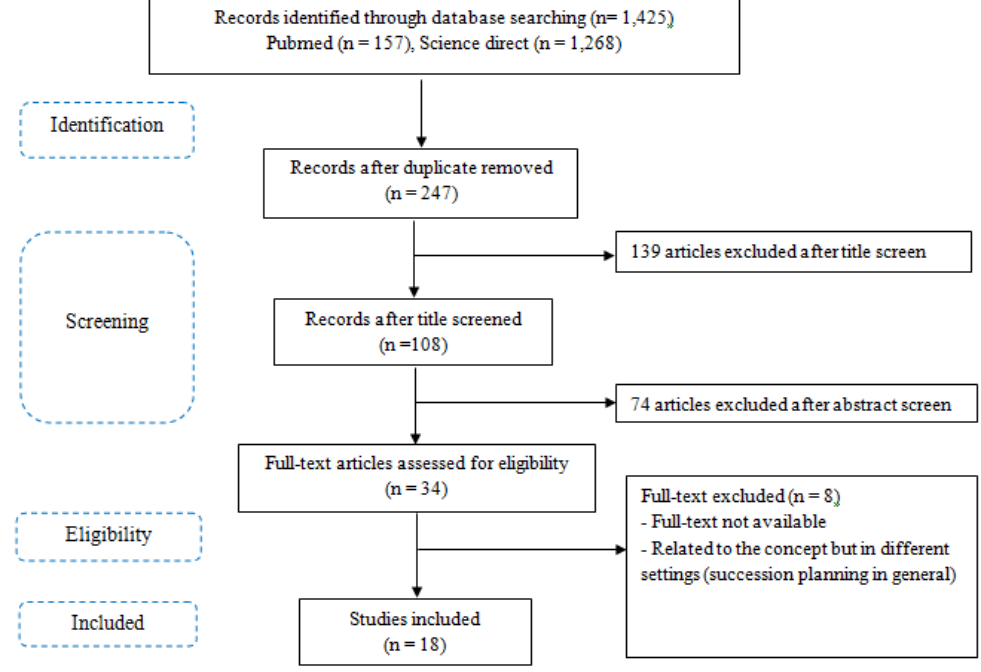
Chart 1. PRISMA Flow Chart